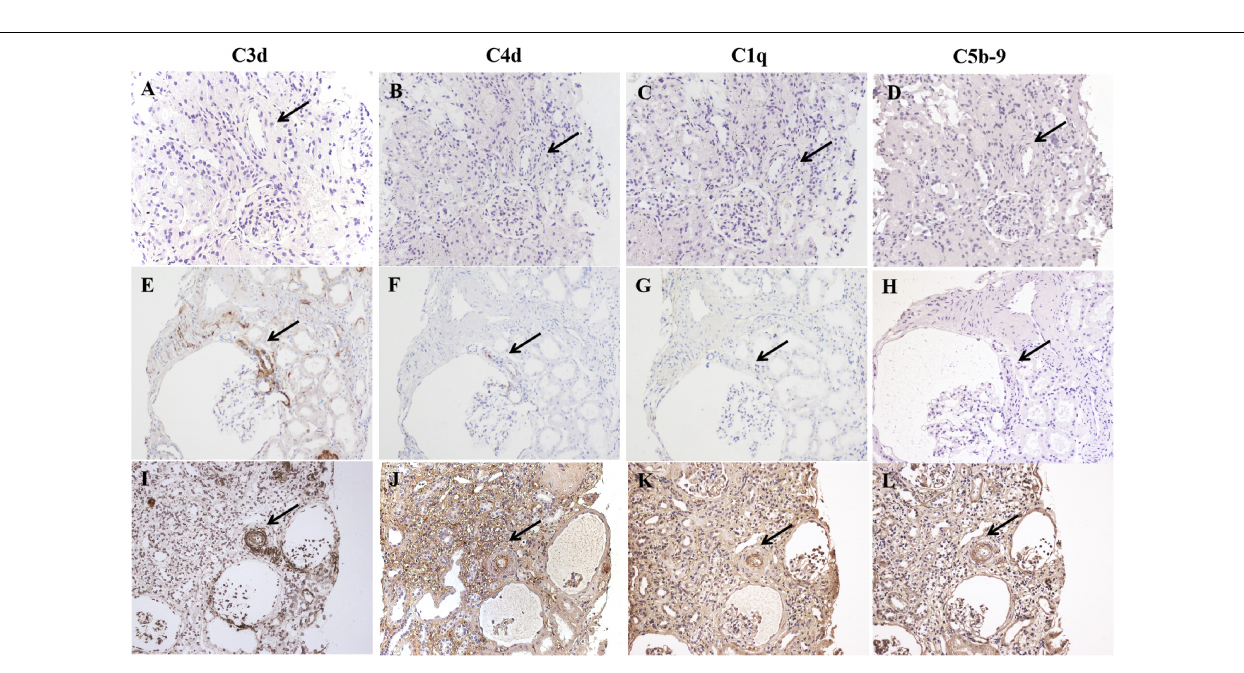
FIGURE 6 | Immunohistochemical staining for C3d, C4d, C1q, and C5b-9 in normal controls (A–D) , arterionephrosclerosis (E–H) and malignant nephrosclerosis (I–L) . The black arrow indicates the same arteriole by different staining. No complement component deposition was found in the normal control (A–D) . C3d was deposited with different intensities on arterioles in arterionephrosclerosis, with weak C4d staining observed in C3d-positive afferent arterioles. No C1q or C5b-9 deposition on arterioles was found (E–H) . All C3d, C4d, C1q, and C5b-9 were found to be positively deposited along the walls of arterioles in malignant nephrosclerosis (Magnification, 200 ×